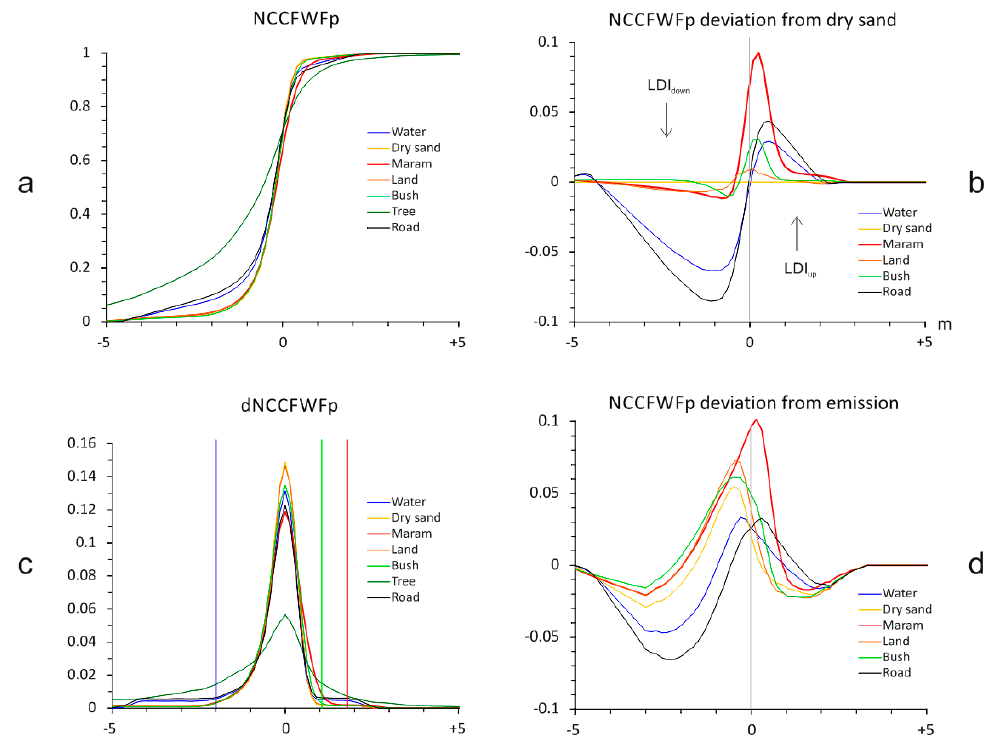
Figure 6. Analysis of normalized cumulative centered FWFp ROI deviations from the dry sand reference: ( a ) NCCFWFp of six ROIs and the dry sand reference ROI; ( b ) NCCFWFp deviations of all ROIs (without trees) from the dry sand reference, ( c ) derivative of the NCCFWFp facilitating its interpretation; and ( d ) NCCFWFp deviations of all ROIs (without trees) from the emitted pulse.